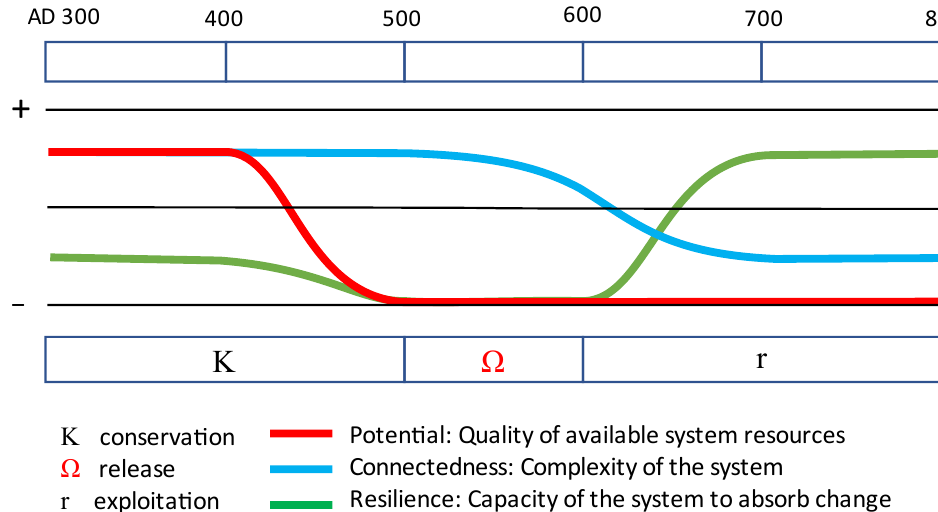
Figure 6. An adaptive cycle for the Basentello Valley landscape.